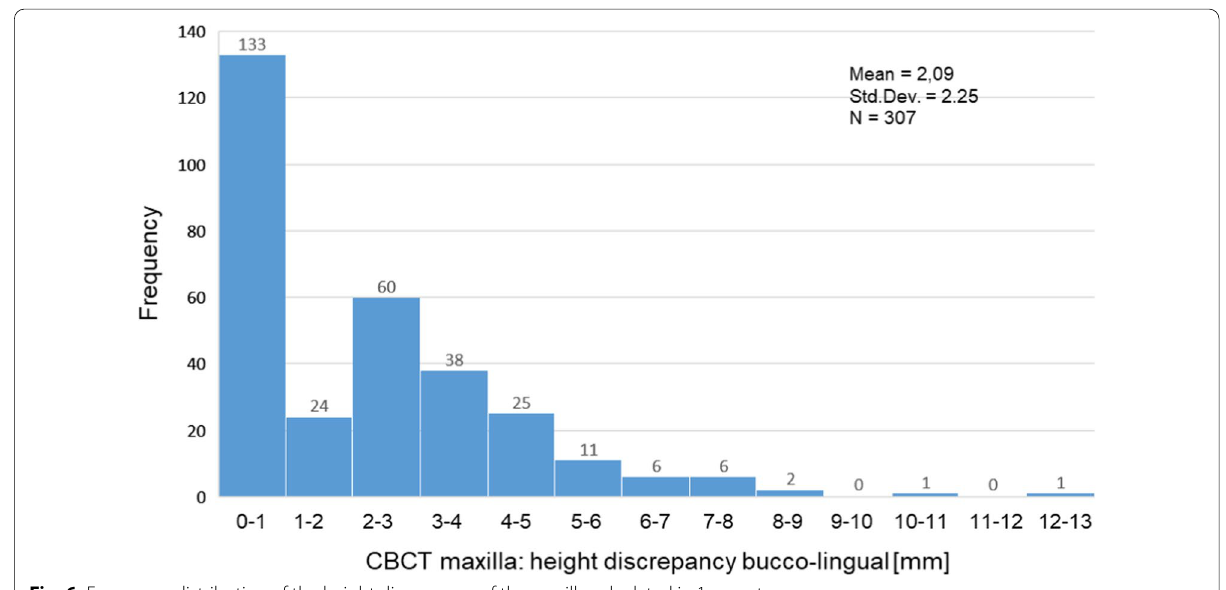
Fig. 6 Frequency distribution of the height discrepancy of the maxilla calculated in 1‑mm steps